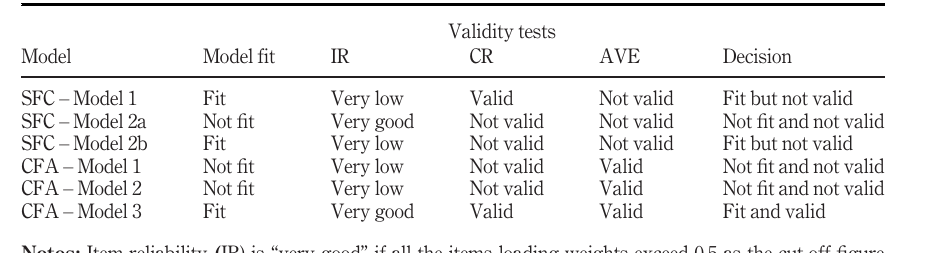
Table 9. Summary of fi